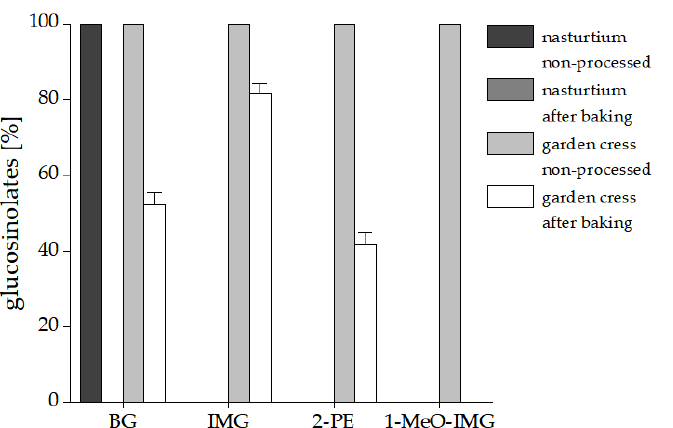
Figure 3. Thermal degradation of GLS in nasturtium and garden cress during the baking process. Results are expressed in % of residual glucosinolates of three treatment replicates analyzed in technical duplicates. Abbreviations: BG: benzyl glucosinolate, IMG: indolyl-3-methyl glucosinolate, 2-PE: 2-phenylethyl glucosinolate, 1-MeO-IMG: 1-methoxy-3-indolylmethyl glucosinolate.